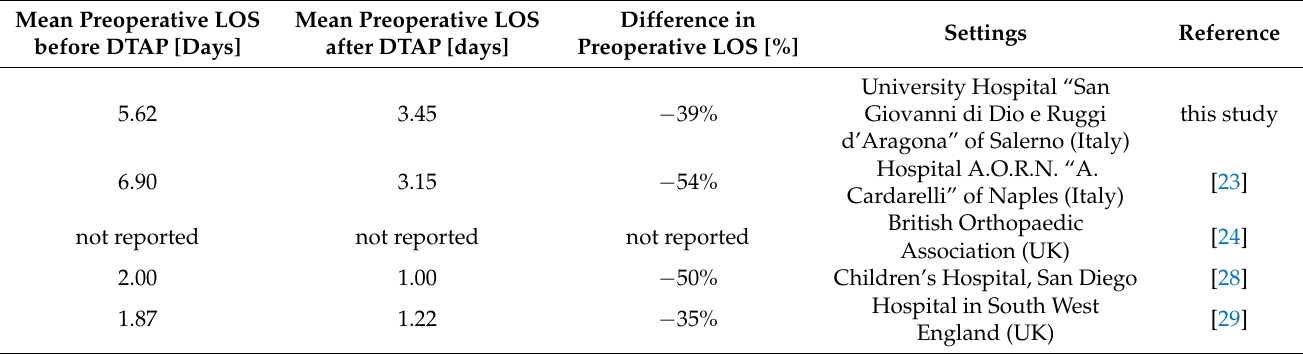
Table 4. Comparison of the results achieved by implementing DTAP for femur fracture in analogous literature works. Mean Preoperative LOS Mean Preoperative LOS Difference before DTAP [Days] after DTAP [days]